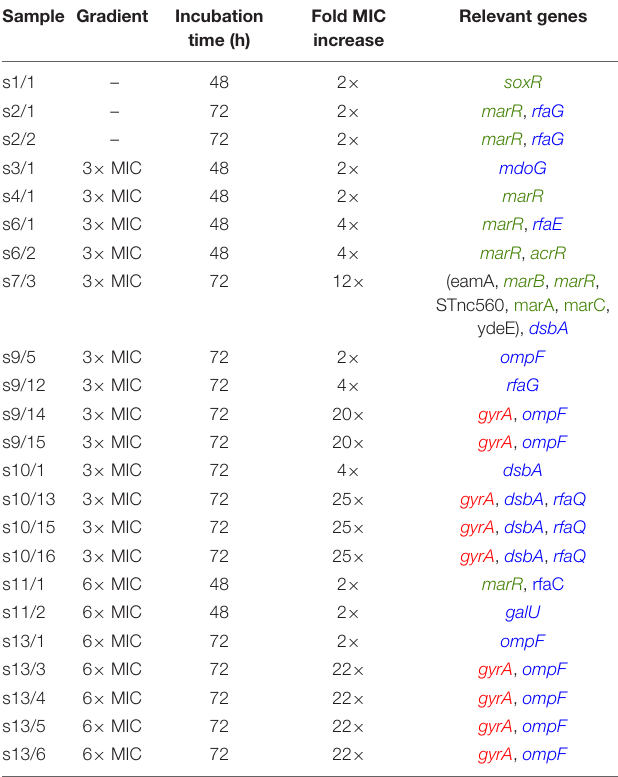
Color codes of the genes: red—specific function in fluoroquinolone resistance, blue—genes associated with the assembly of the outer membrane, green—genes related to efflux